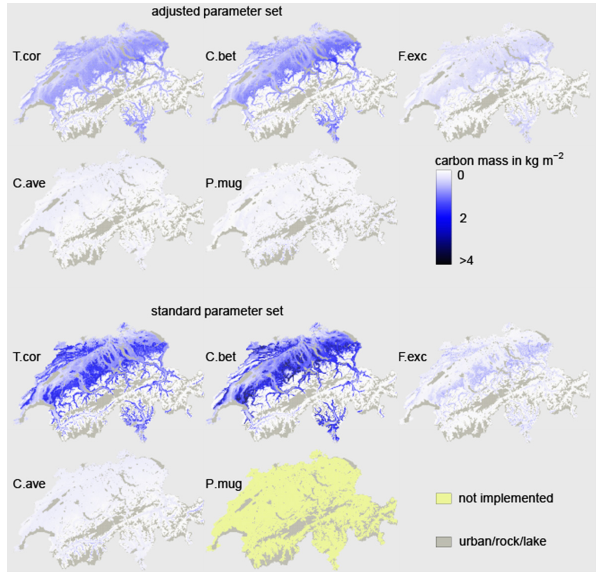
Figure D5. Carbon mass simulated with the adjusted and standard parameter set for minor species at 2000. C.bet: Carpinus betulus ; C.ave: Corylus avellana ; F.exc: Fraxinus excelsior ; P.mug: Pinus mugo ; T.cor: Tilia cordata . Please note that a different color gradient was used than in Fig. D3.